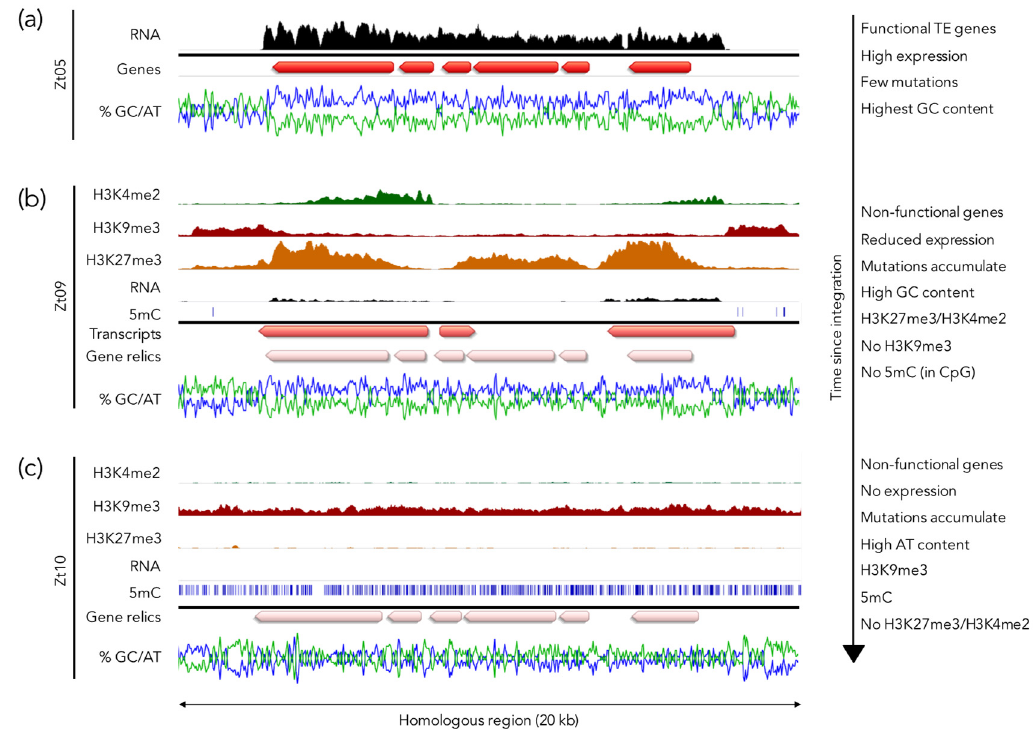
Figure 4. H3K27me3 as part of an ancestral genome defense. Homologous regions on different chromosomes in three Z. tritici isolates illustrate a model for H3K27me3-mediated silencing and step-wise inactivation of GC-rich regions on a short evolutionary timescale. ( a ) A recent transposon insertion in a subtelomeric region in the isolate Zt05. The GC-rich gene cluster containing transposon-related genes is flanked by AT-rich repetitive sequences. The genes inside the cluster are highly expressed. ChIP-seq and 5mC data are currently not available for this isolate. ( b ) A homologous region in the isolate Zt09 is marked by H3K27me3 and H3K4me2 enrichment in the GC-rich region and H3K9me3 in the flanking AT-rich regions. Compared to Zt05, there are ~600 mutations, mainly transitions, in the GC-rich region. Some sequences are expressed but the expression level is relatively low, and the genes are likely non-functional due to the numerous mutations. Very few 5mC sites are present in H3K9me3 regions as this isolate is lacking the DNA methyltransferase Dim2 [162]. ( c ) The isolate Zt10 accumulated > 1000 mutations in a homologous region, decreasing the GC content to ~49% (~60% in Zt05). The entire region is covered by H3K9me3 and 5mC and there is no detectable transcriptional activity or H3K4me2. The isolate Zt10 contains a functional DNA methyltransferase Dim2 [162]. Data used to generate this figure are from [37,162,163], and Möller